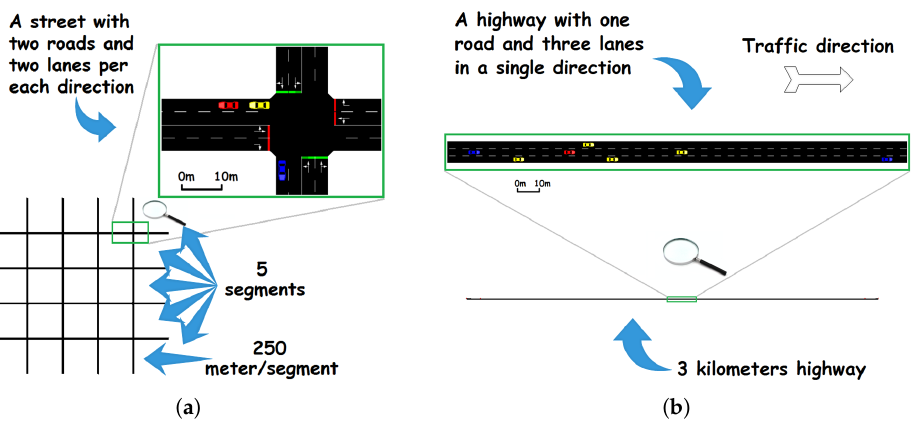
Figure 8. Simulation scenarios illustration. ( a ) The Manhattan scenario illustration. ( b ) The highway scenario